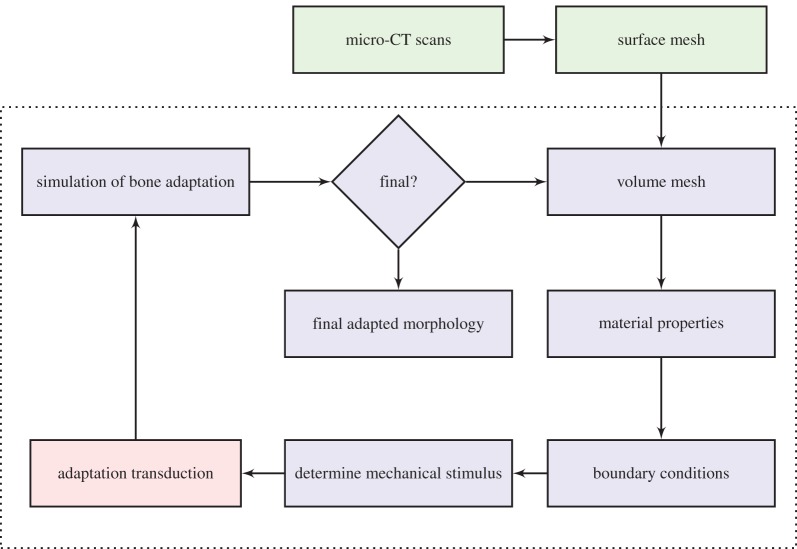
Adaptation algorithm flowchart. Shade indicative of software used: Mimics (green), ABAQUS (blue) and Matlab (red). Steps inside dashed line are automated.